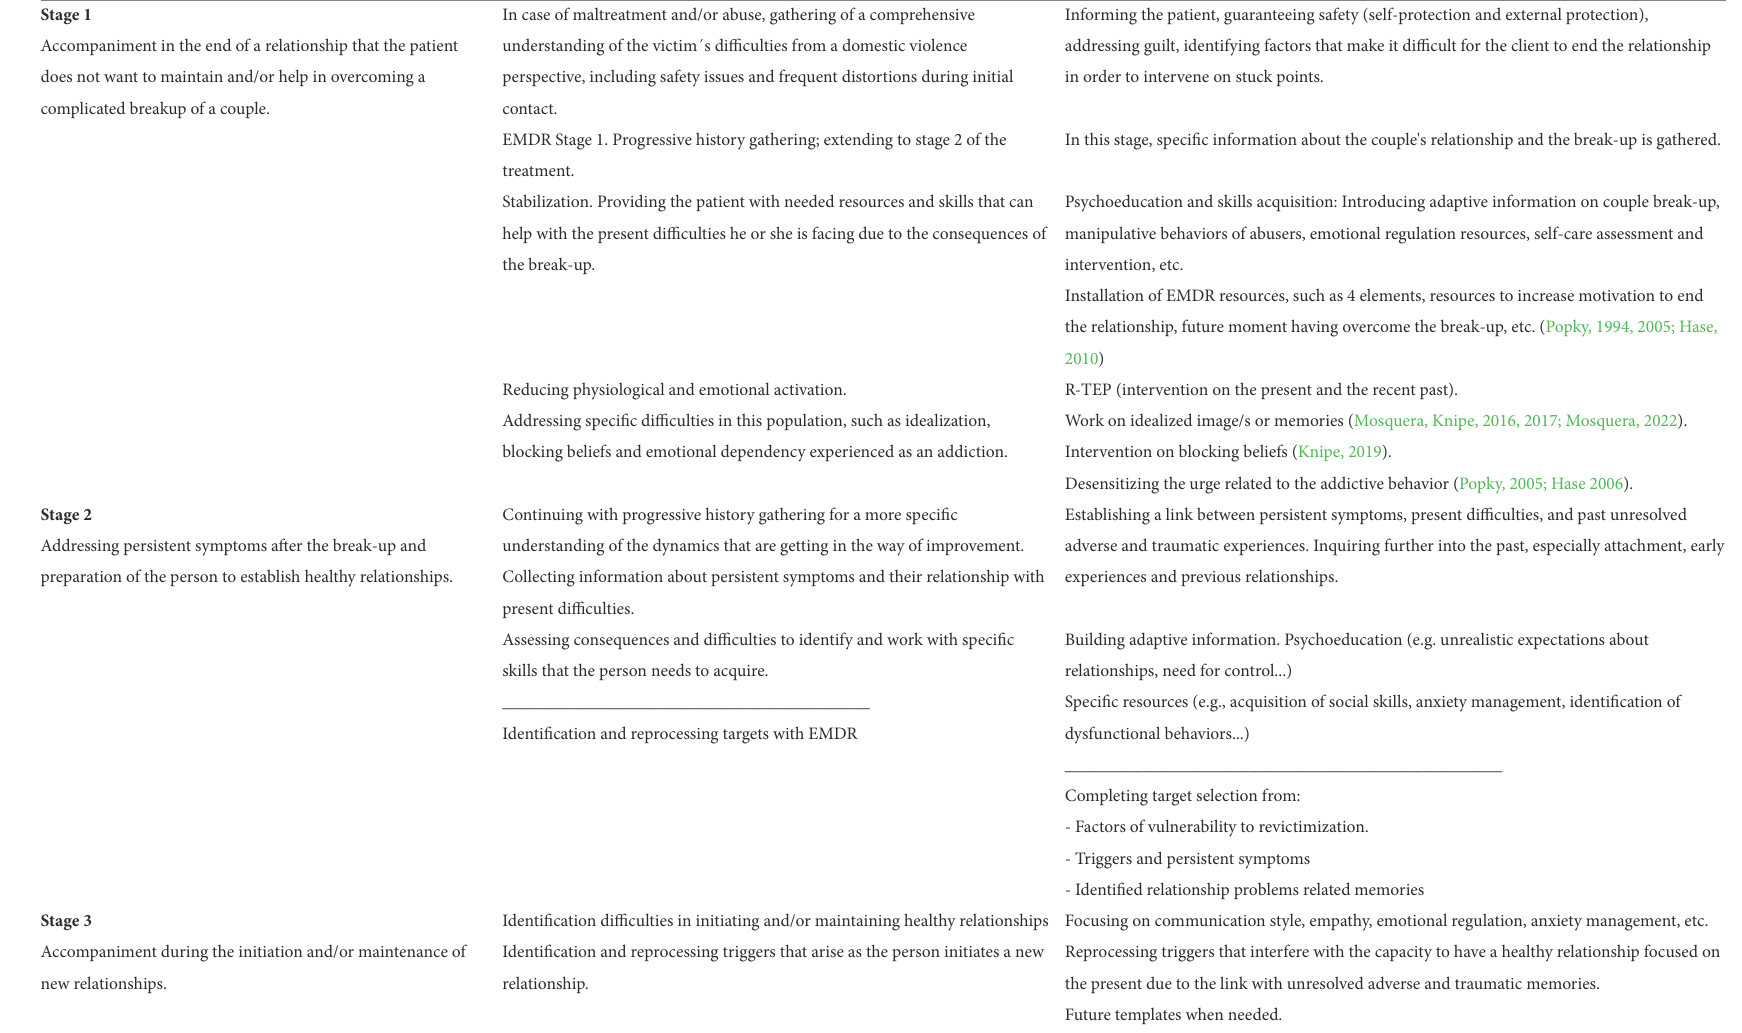
Stages of the intervention Stage